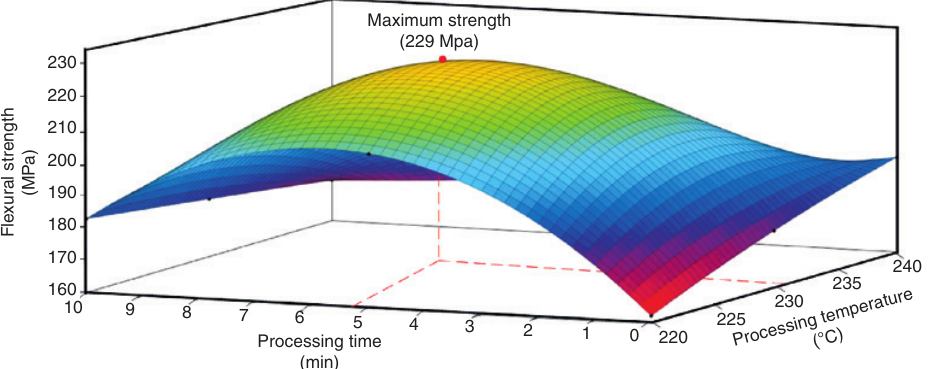
Figure 12: The effect of processing time and temperature on the flexural strength of PVC/fiberglass composites in constant processing pres- sure of 1.6 MPa.